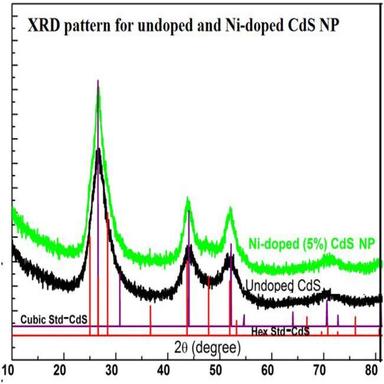
XRD patterns for un-doped & 5%eNi doped 0.5M CdS NP ploted with cubic and hexagonal CdS standards.